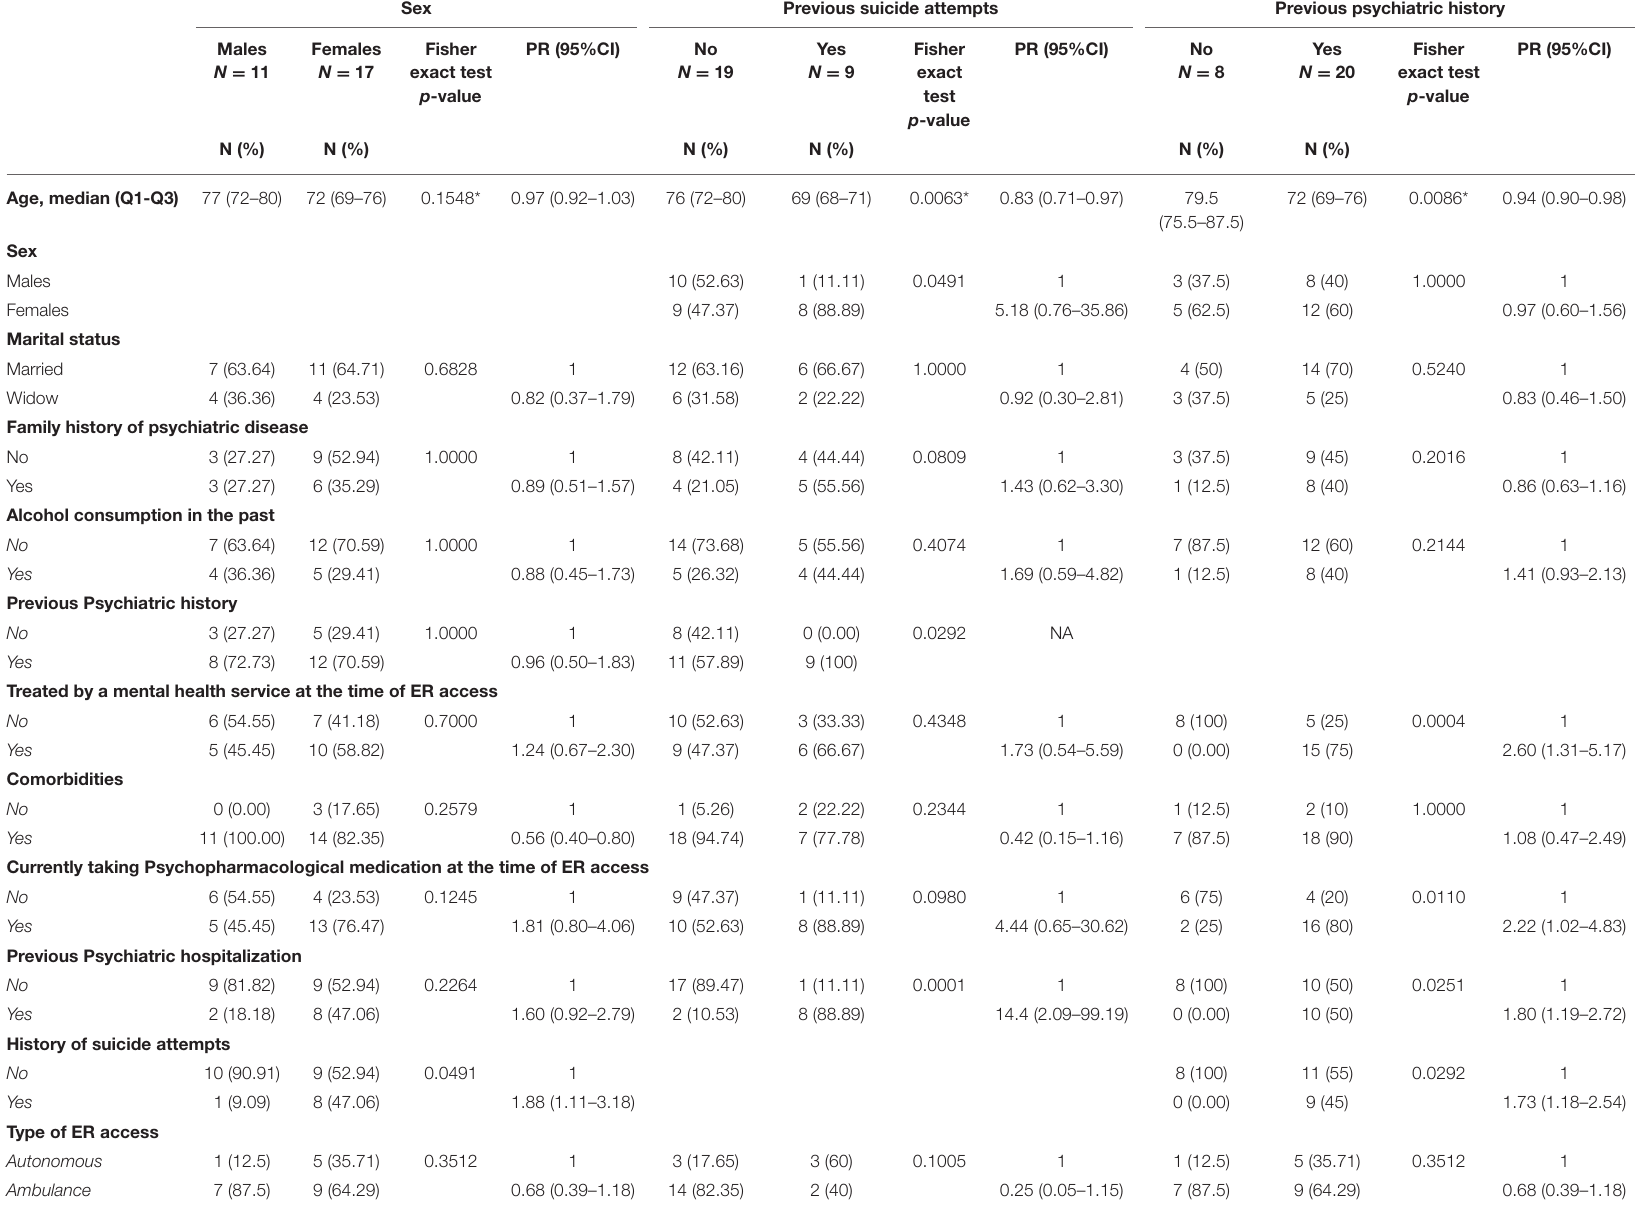
TABLE 2 | Results from comparison by gender, previous history of suicide attempt and previous psychiatric history. Previous suicide attempts Previous psychiatric